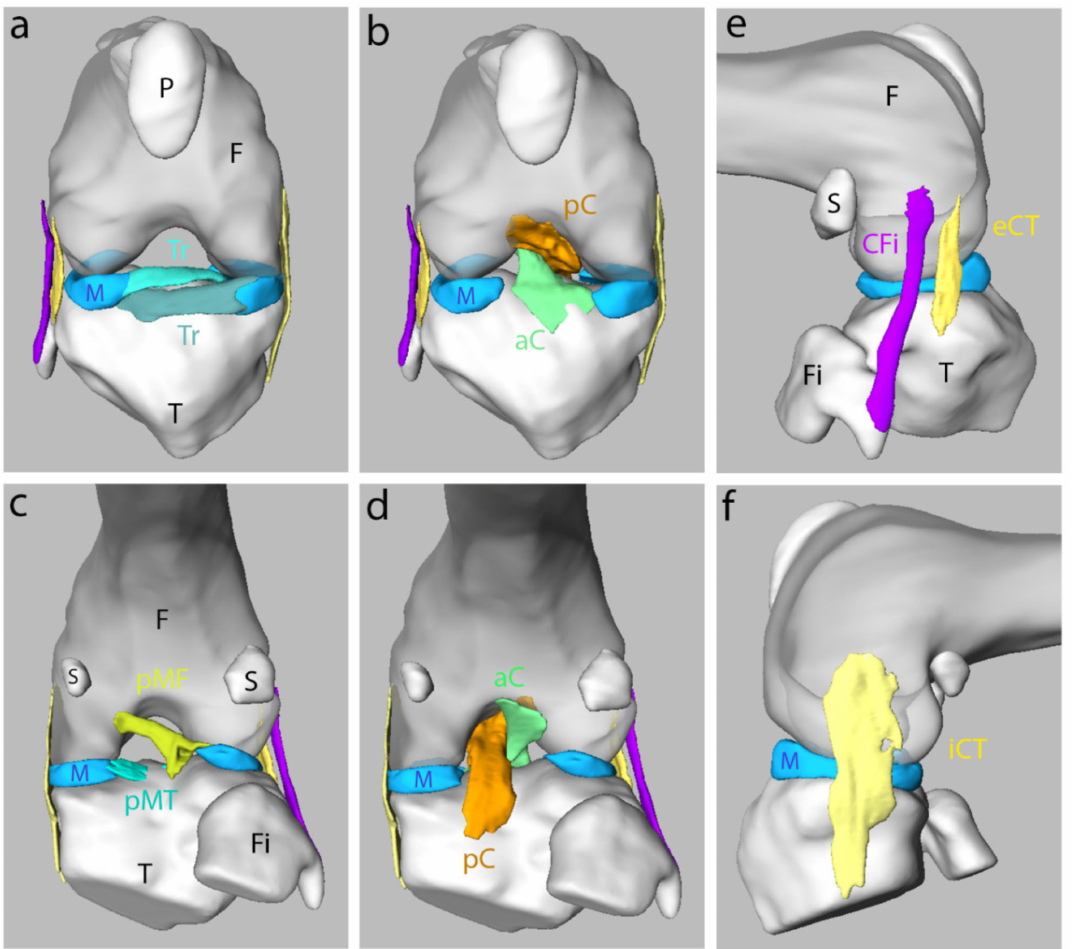
Figure 6. 3D representation of the ligaments and bones in an adult mouse knee joint. Anterior ( a , b ), posterior ( c , d ) and lateral views ( e , f ). The meniscus (M) is represented in light blue. F: femur, T: tibia, Fi: fibula, P: patella, S: sesamoid bones, pMF: posterior menisco-femoral ligament, pMT: posterior menisco-tibial ligament, iCT and eCT: internal and external tibial collateral, aC and pC: anterior and posterior cruciate ligament, Tr: transverse ligament, CFi: fibular collateral